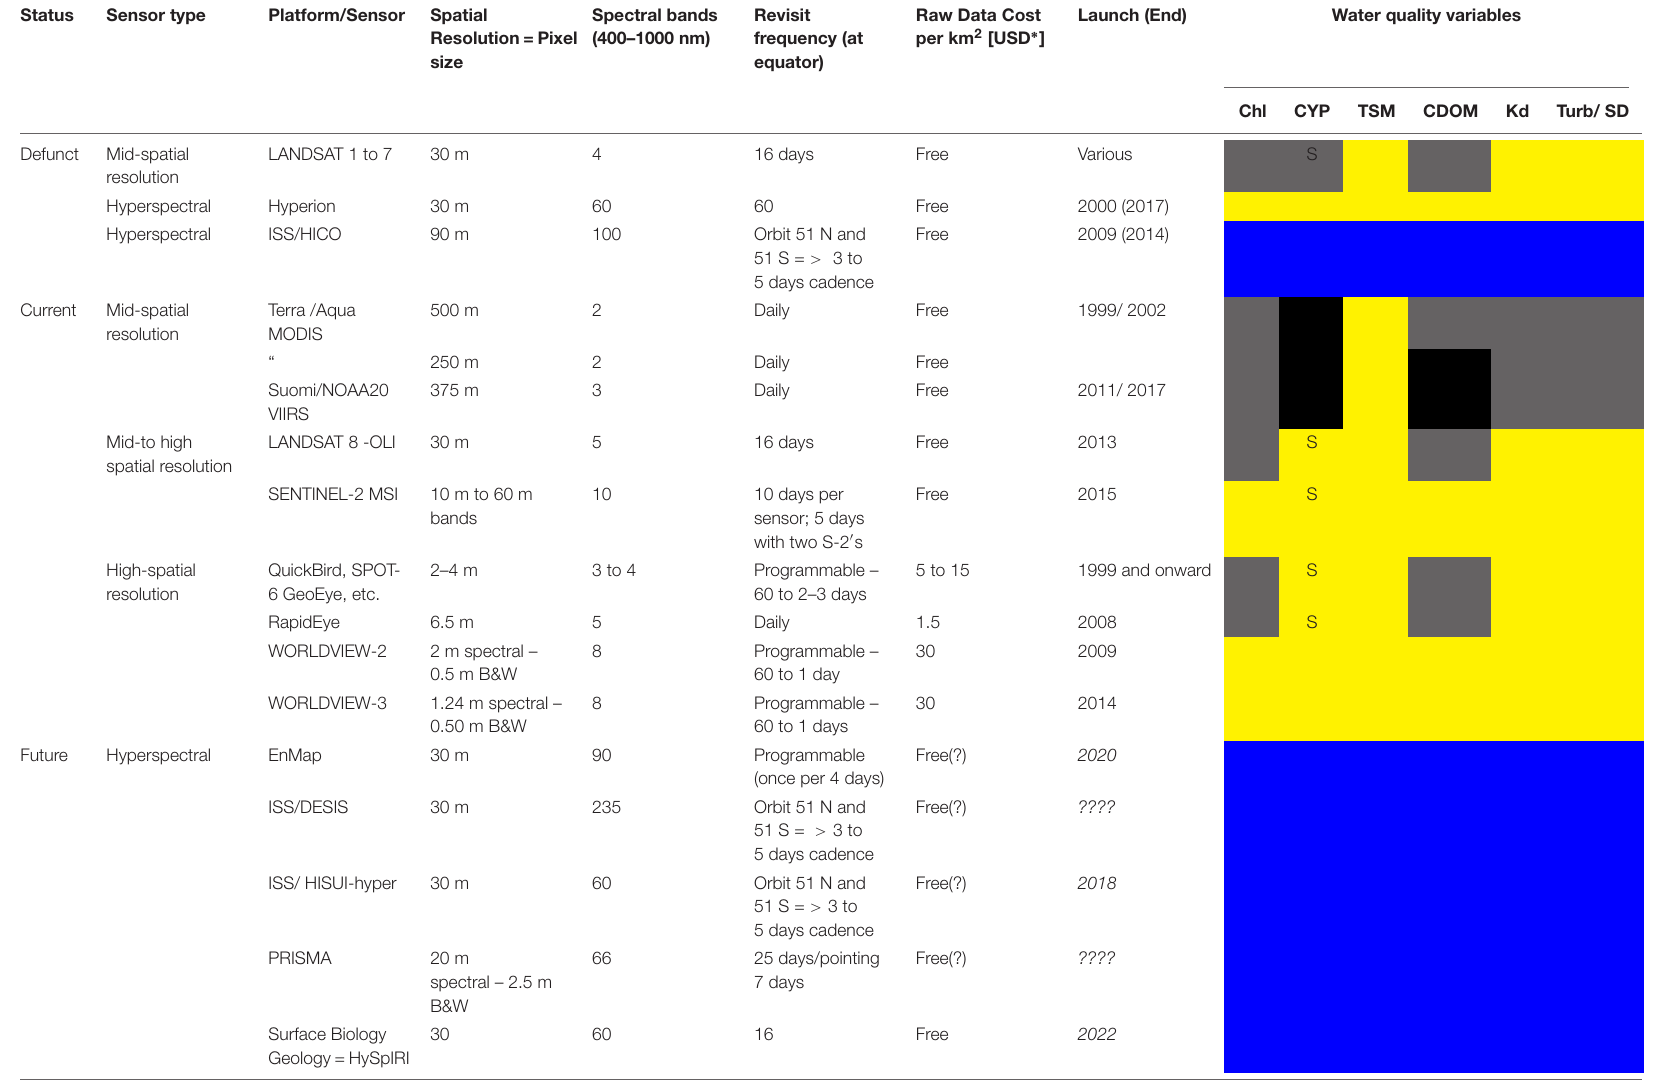
TABLE 3 | Recent, existing, and near-future satellite sensor systems of relevance for inland and near-coastal water quality (revised and updated after International Ocean Colour Coordinating Group [IOCCG],